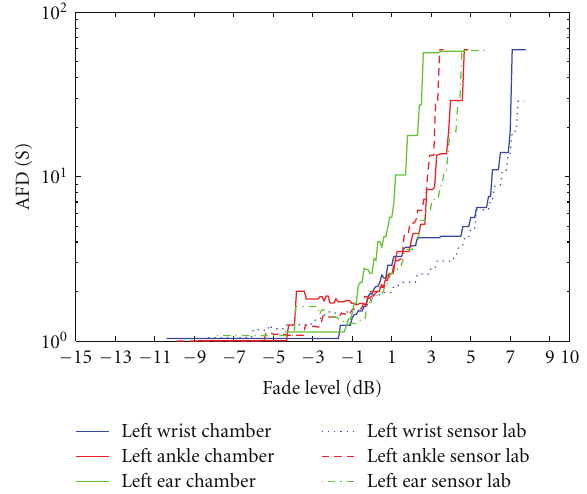
Figure 14: Comparison of average fade duration for three on-body channels as left wrist, left ankle, and left ear when subject was walking measured in the chamber and indoor